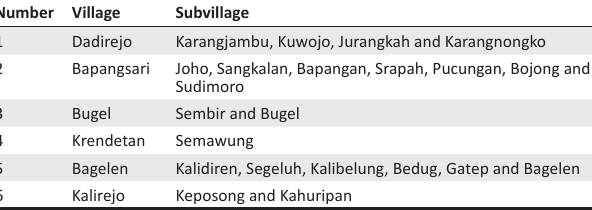
FIGURE 4: Flowchart of flood inundation participatory mapping.